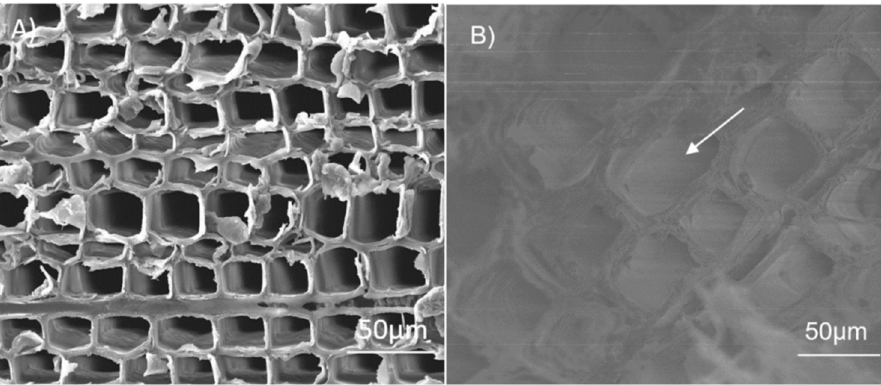
Figure 2. SEM images of the wood ( A ) before and ( B ) after PEG-1000 impregnation [41].